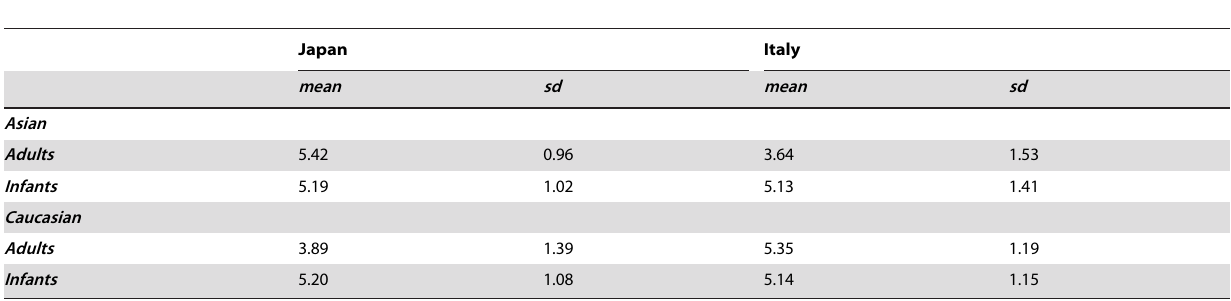
Table 2. Means and Standard Deviations of the Willingness to